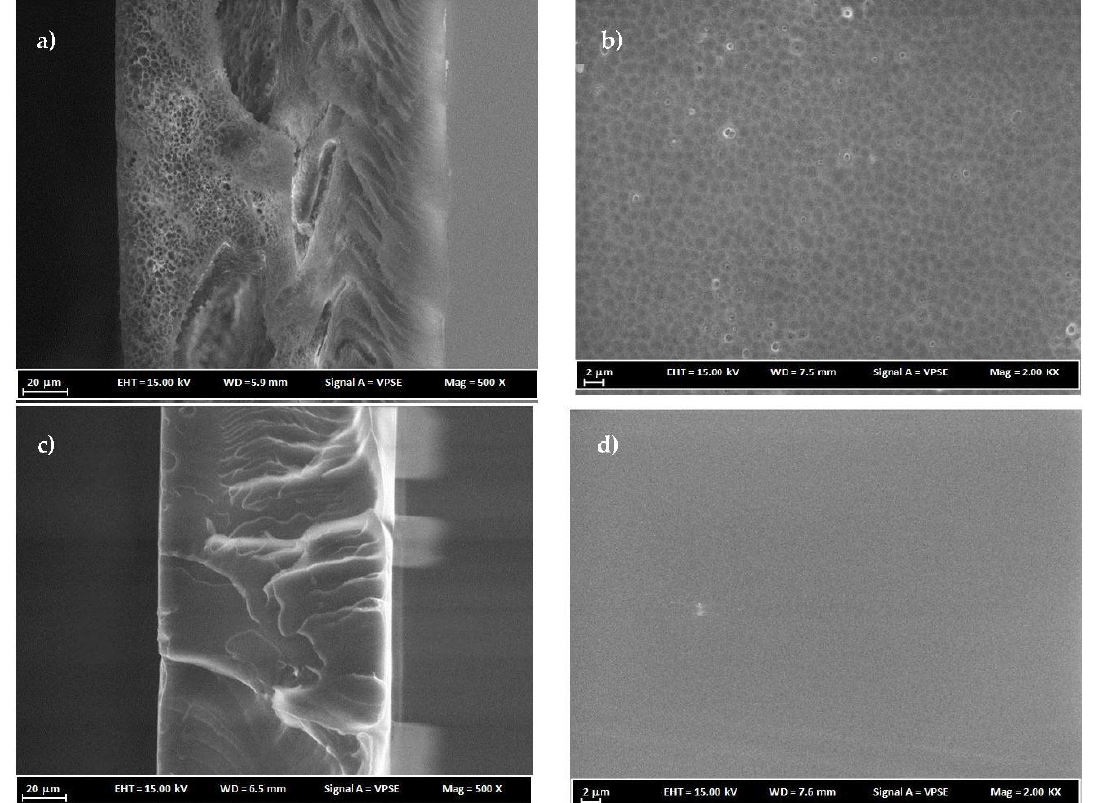
Figure 5. FESEM cross-sectional and surface images of membranes ( a , b ) 16 wt % PC/NMP and ( c , d ) 16 wt % PC/DCM.